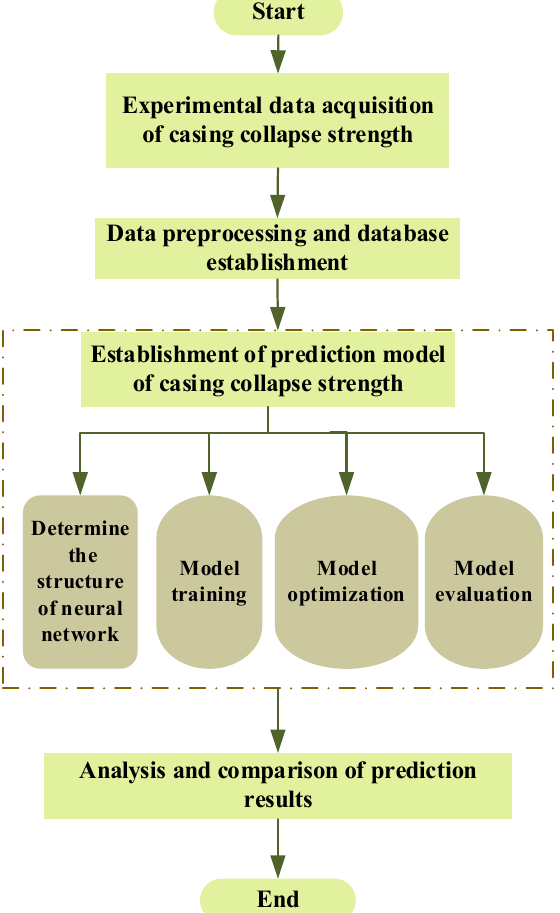
Figure 1. Flow chart of prediction scheme of casing collapse strength.